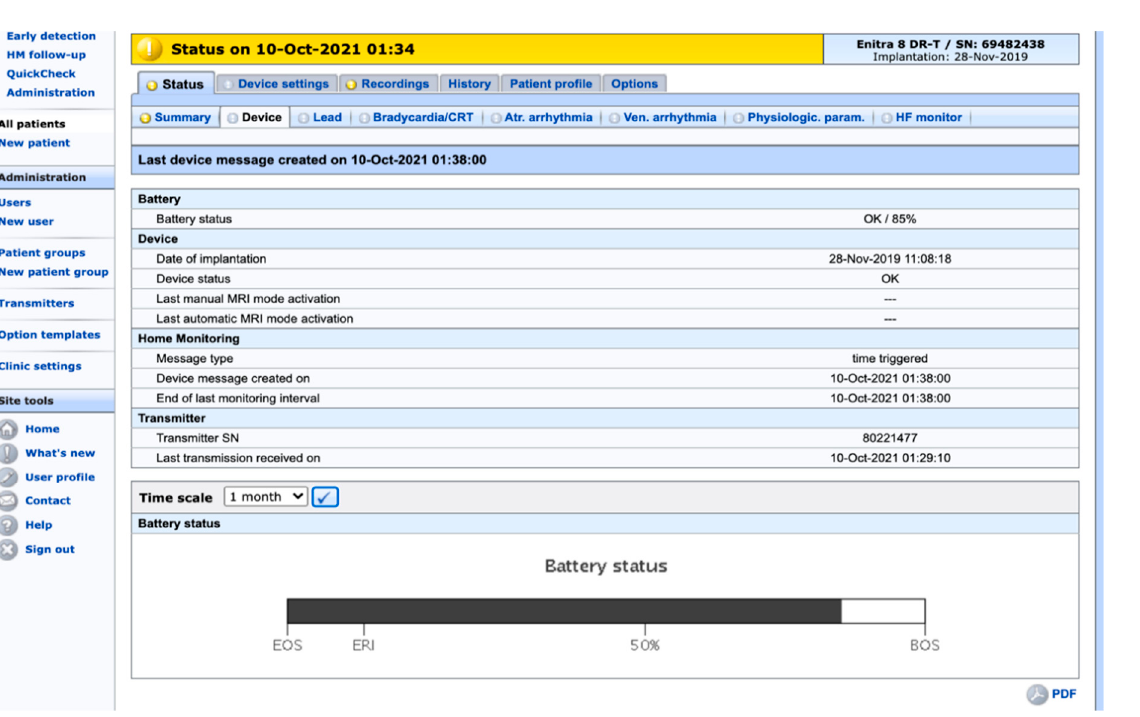
Figure 2. Screenshot from a web page in one of the RM systems (Biotronik Home Monitoring™). A number of pages/fold ‐ ers are available for each patient.